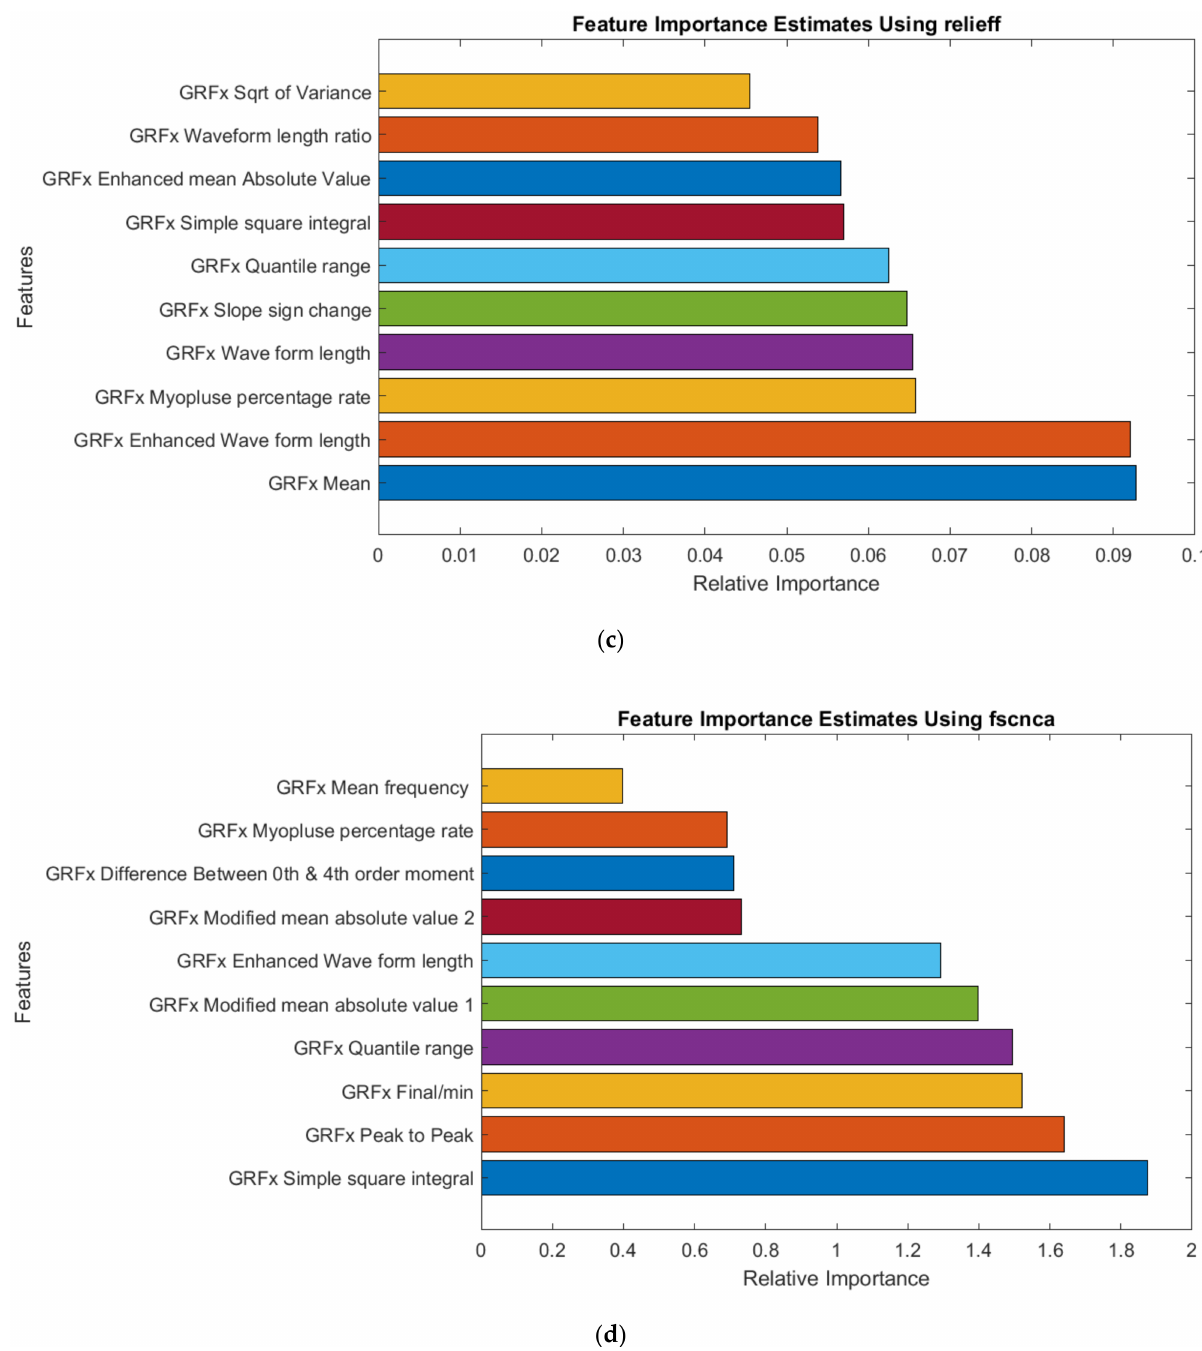
Figure 7. Top-ranked features from GRFx signal by ( a ) Chi-Square, ( b ) mrmr, ( c ) Relieff, ( d ) fscnca feature selection